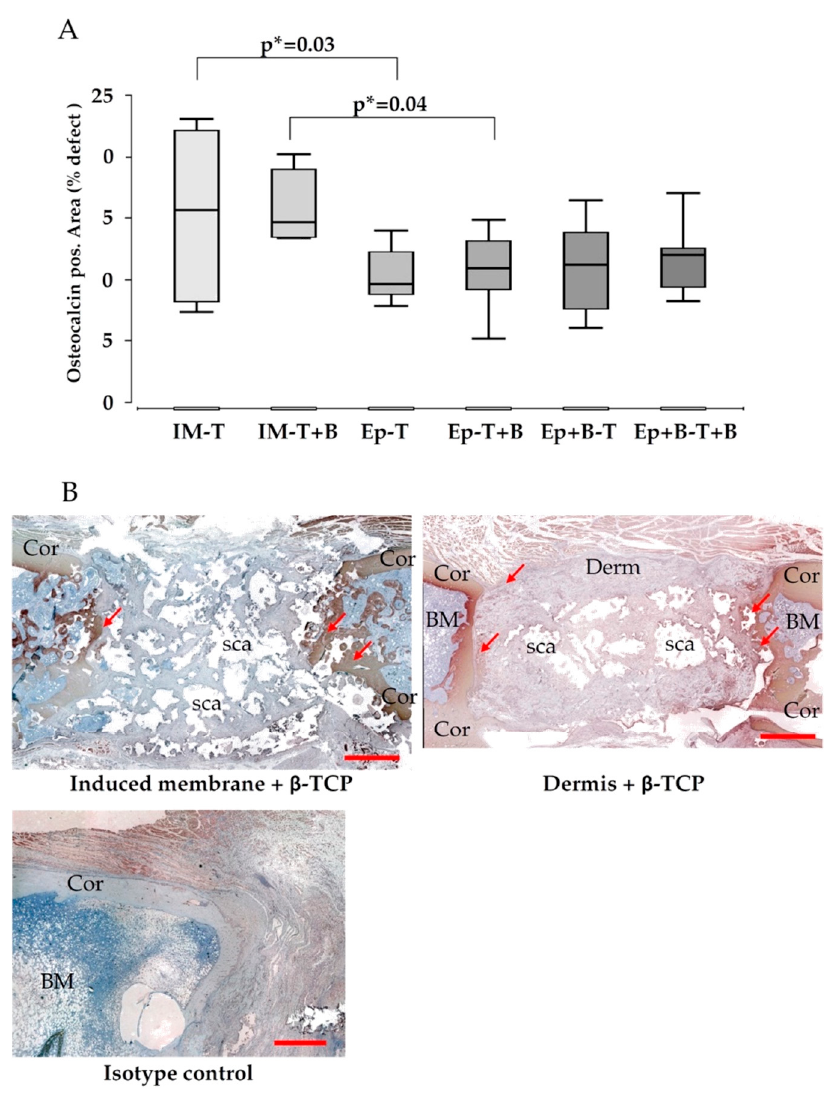
Figure 5. Data of histomorphometric evaluation of osteocalcin positive areas within the defect ( A ). Osteocalcin expression was increased in induced membrane-groups. Representative osteocalcin- stainings are shown in ( B ). Upper row left induced membrane, right decellularized dermis. Isotype control in the lower row. p * = uncorrected p-value, indicates a statistical trend. Cor = corticalis, Derm = decellularized dermis, IM = induced membrane, sca = scaffold. BM = bone marrow. Size bar upper row 2 mm, size bar isotype control 100 μ m.